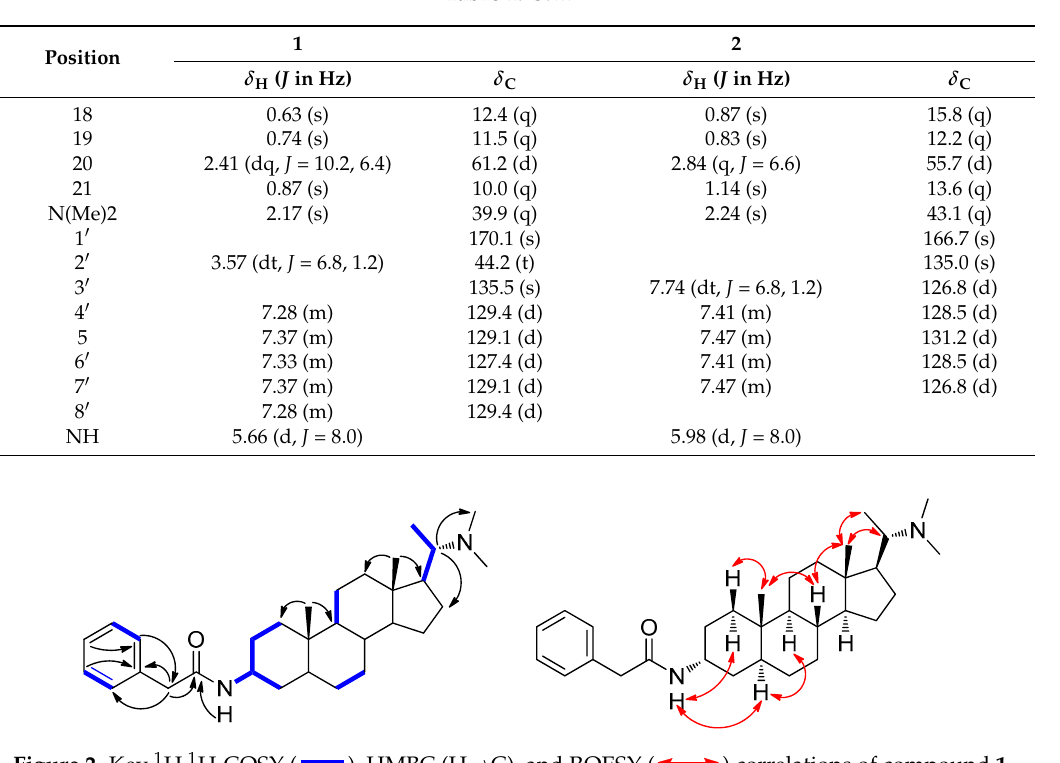
Figure 1. Structures of compounds 1 – 4 .